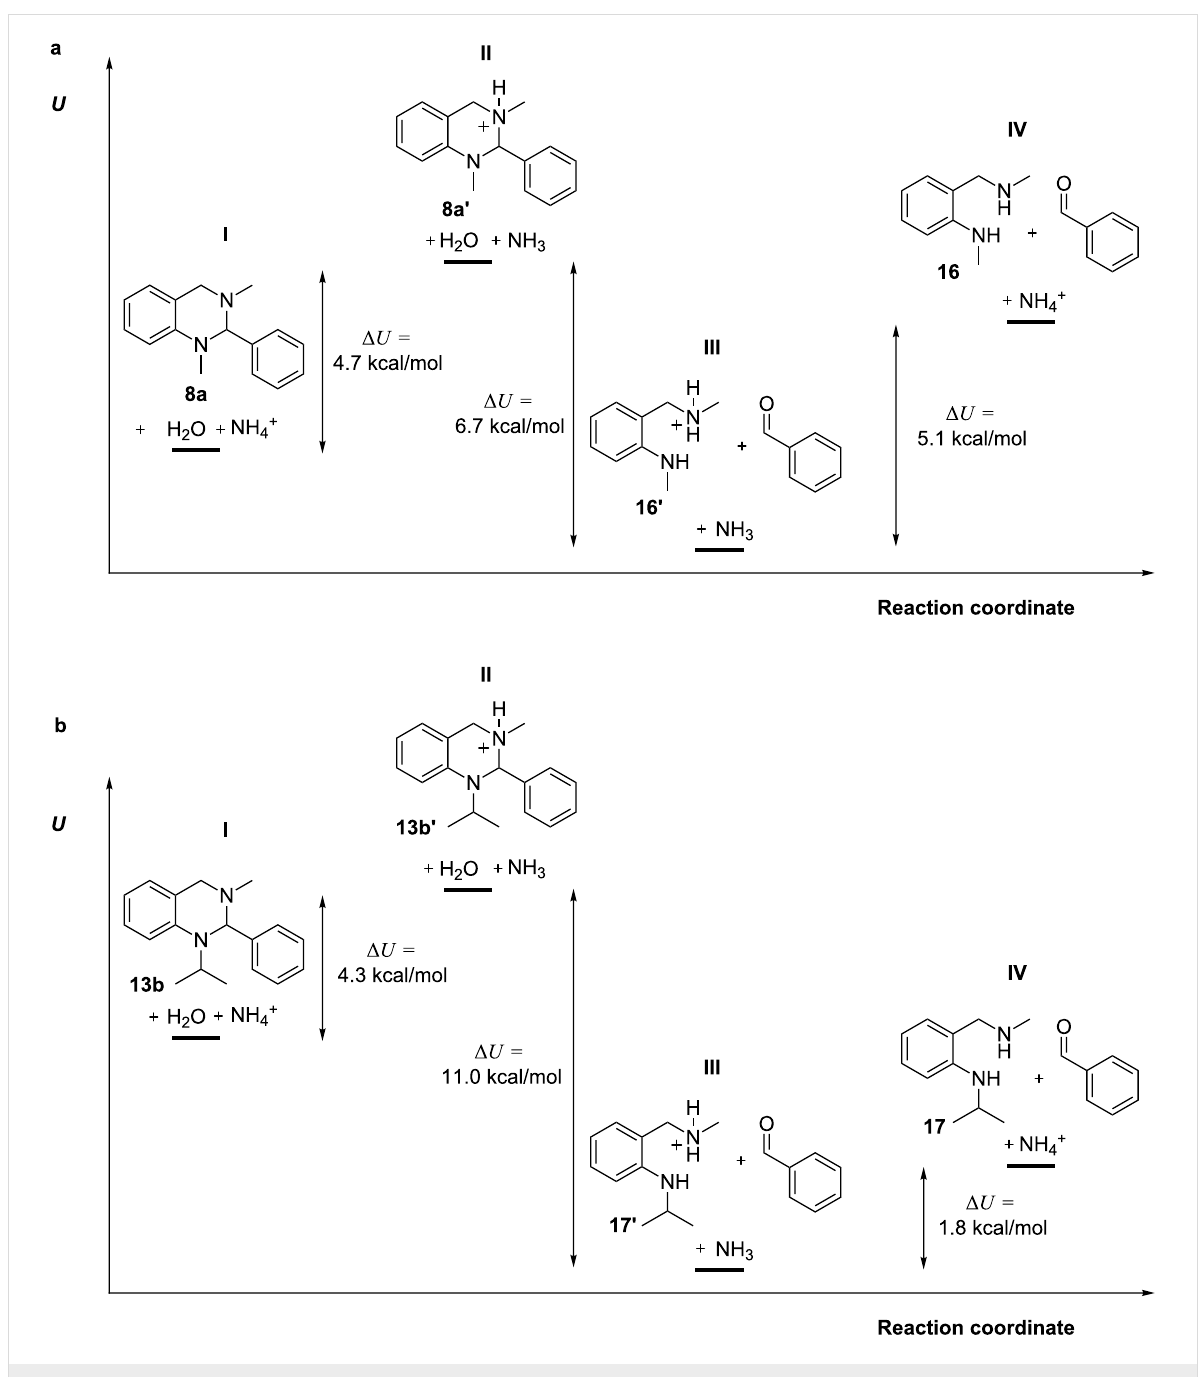
Figure 5: Differences in energy along the reaction coordinate using the functional B3LYP-D3 for the hydrolysis of (a) compound 8a and (b) com- pound 13b in aqueous environment.